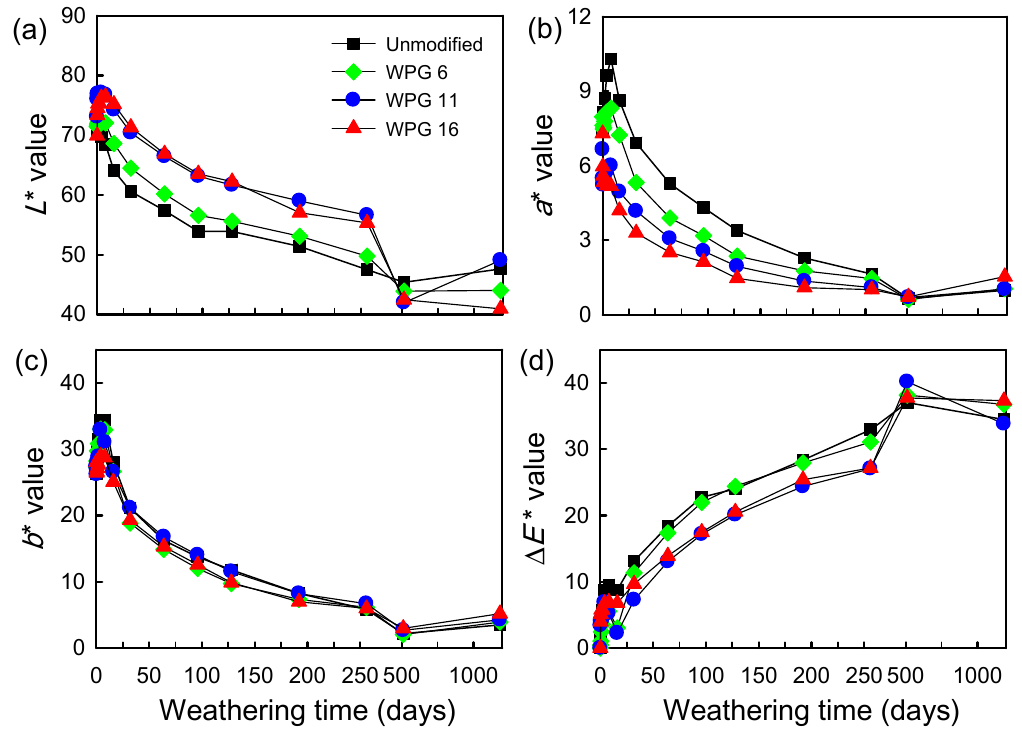
Figure 3. Effect of acetylated veneers on the surface color of vWPCs after natural weathering for 1185 days. ( a ) L *, ( b ) a *, ( c ) b *, and ( d ) Δ E * values. Values are the mean ( n = 5).